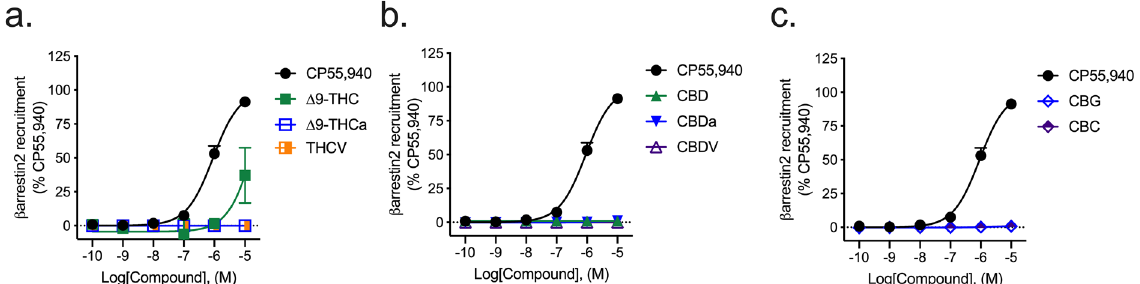
Figure 4. hCB1R-dependent recruitment of βarrestin2. hCB1R-dependent recruitment of βarrestin2 was quantified in PathHunter CHO cells stably expressing hCB1R and treated with 0.1 nM–10 µM ( a ) THC-like compounds; ( b ) CBD-like compounds; or ( c ) CBG, or CBC for 90 min. Data were fit to a variable slope (4 parameter) non-linear regression in GraphPad (v. 8). n ≥ 6 independent experiments performed in triplicate. E Max refers to the top of the concentration–response curve. Data are expressed as mean ± SEM. EC 50 and E max are reported in Table